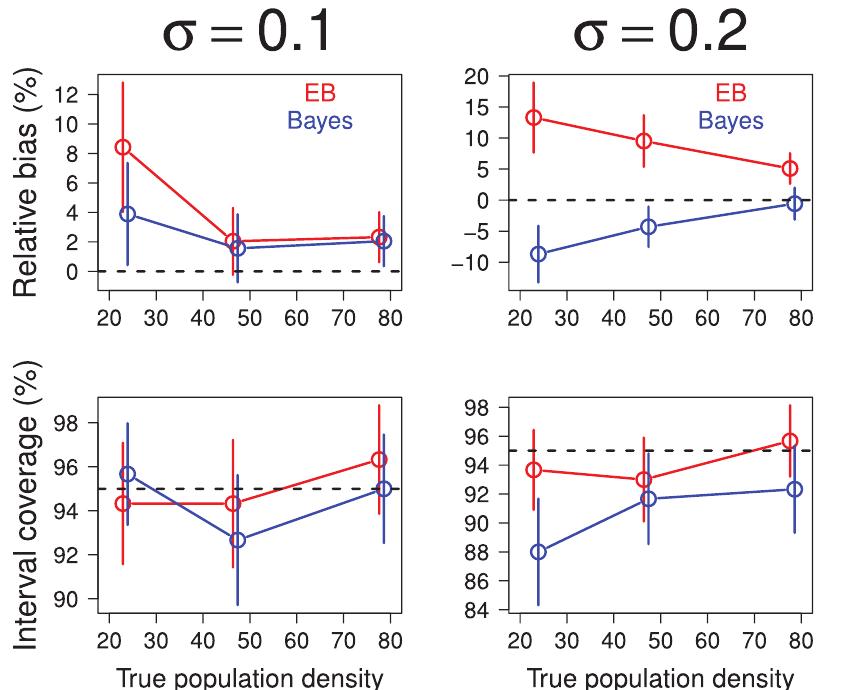
Figure 7. Comparison of emprical Bayes and Bayes estimates of population abundance computed from analyses of simulated recaptures in area-search surveys. Estimates of relative bias are plotted in upper row. Estimates of frequentist coverage of 95% credible or confidence intervals are plotted in lower row. Error bars indicate 95% confidence intervals.